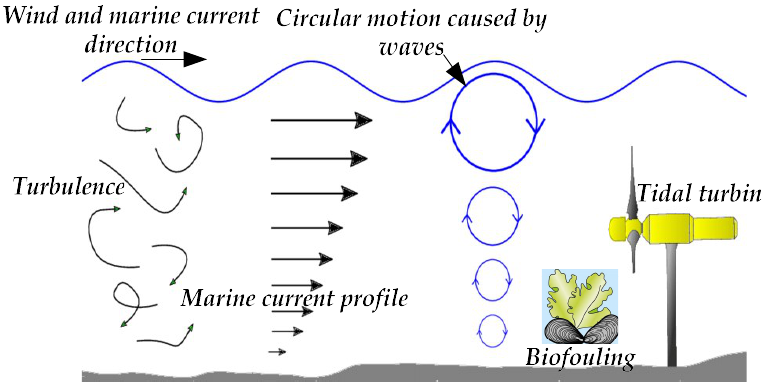
Figure 2. TST harsh environment conditions.